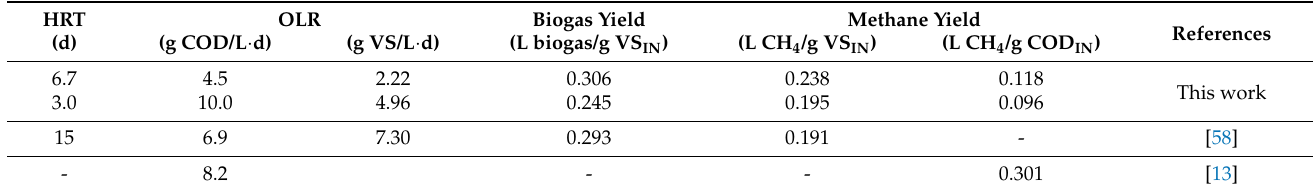
Table 4. Anaerobic digestion performance: gas